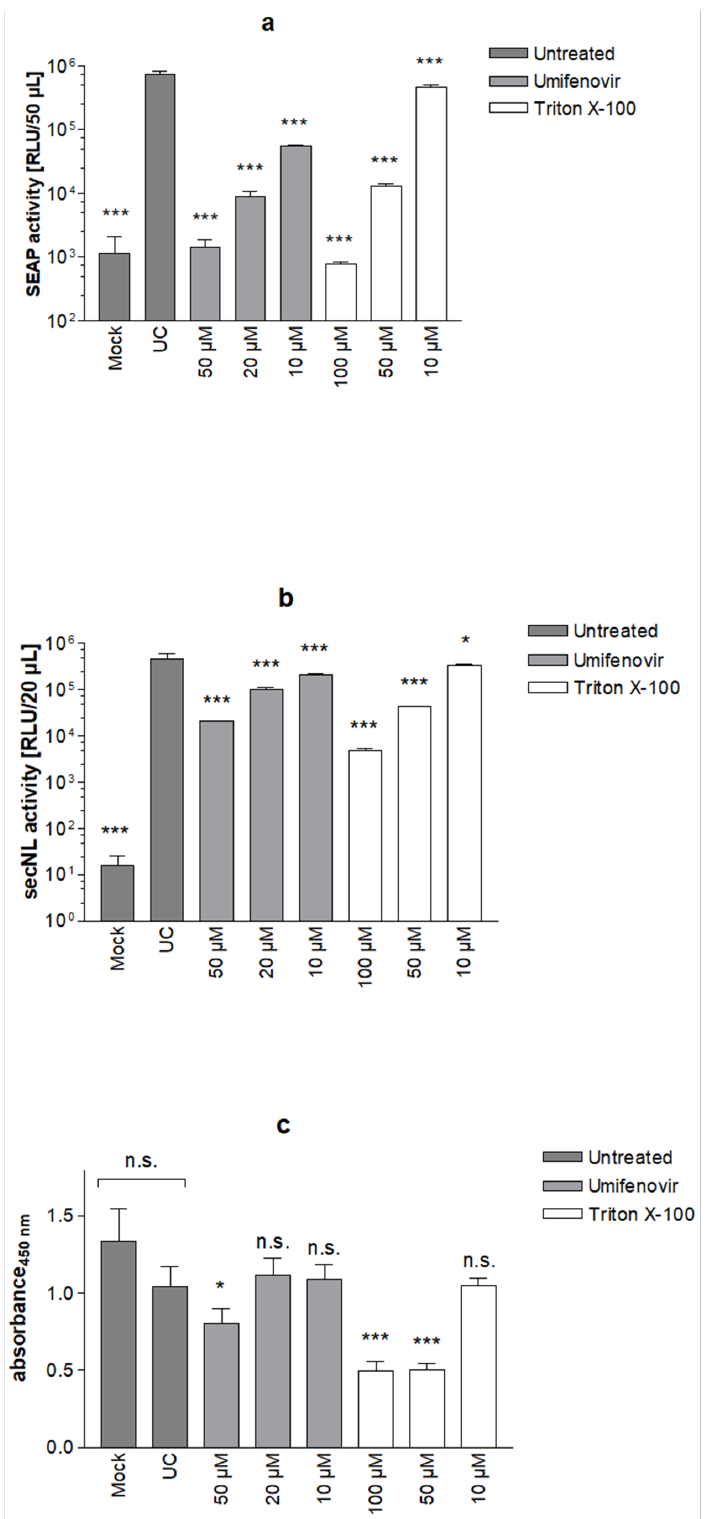
Figure 9. SARS-CoV-2 SRFIA on 96-well plates. Fusion assay on 96-well plates with umifenovir (10, 20, and 50 µ M) or Triton X-100 detergent (10, 50, 100 µ M) treatment, measurement was performed after 48 h of incubation; ( a ) SEAP levels, ( b ) secNLuc levels, ( c ) XTT values. Mock: no S protein/no secNLuc plasmid, no treatment. Significance is indicated compared to untreated control (UC). Data represent means SD from triplicate, n.s. not significant, p < 0.05 (*) and p < 0.001 ±